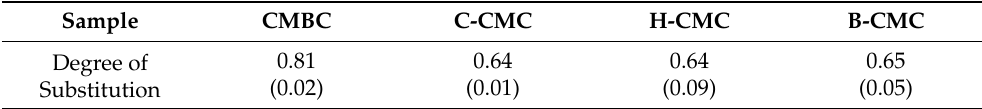
Table 1. Degree of substitution of CMBC and CMC